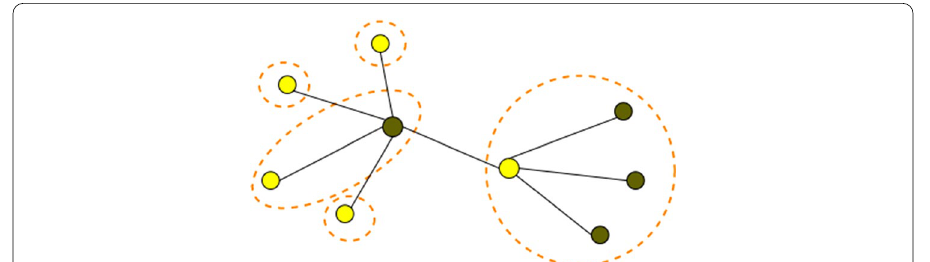
Fig. 3 An example covering with the random sequential algorithm with r B = 1 . The center nodes of the boxes are colored by